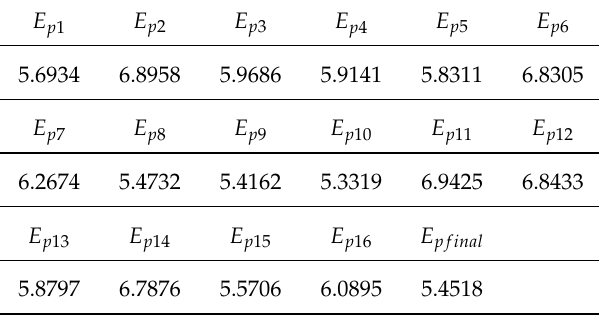
Table 1. The image entropies of subimages and final fusion image ( SNR = 8 dB, ς 2 n = 4). E p